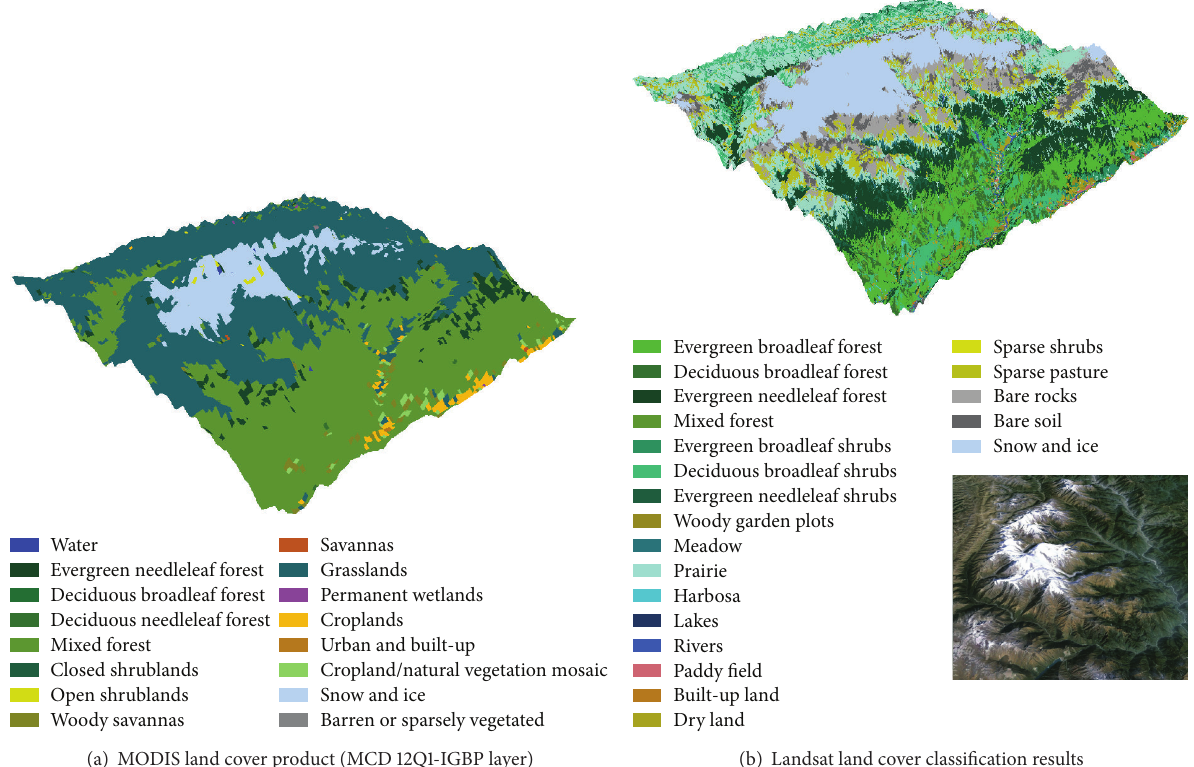
Figure 4: Land cover map classification results from MODIS and Landsat data of Mount Gongga area in China in